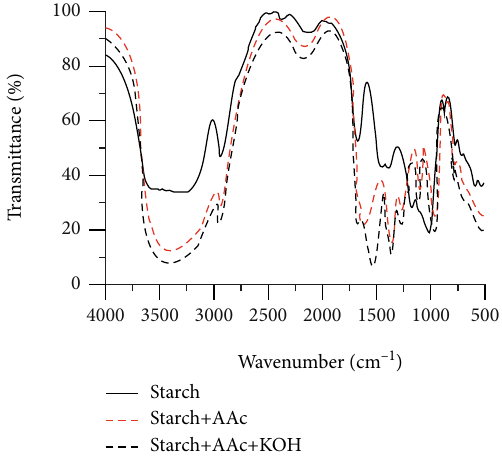
Figure 8: FTIR spectra of